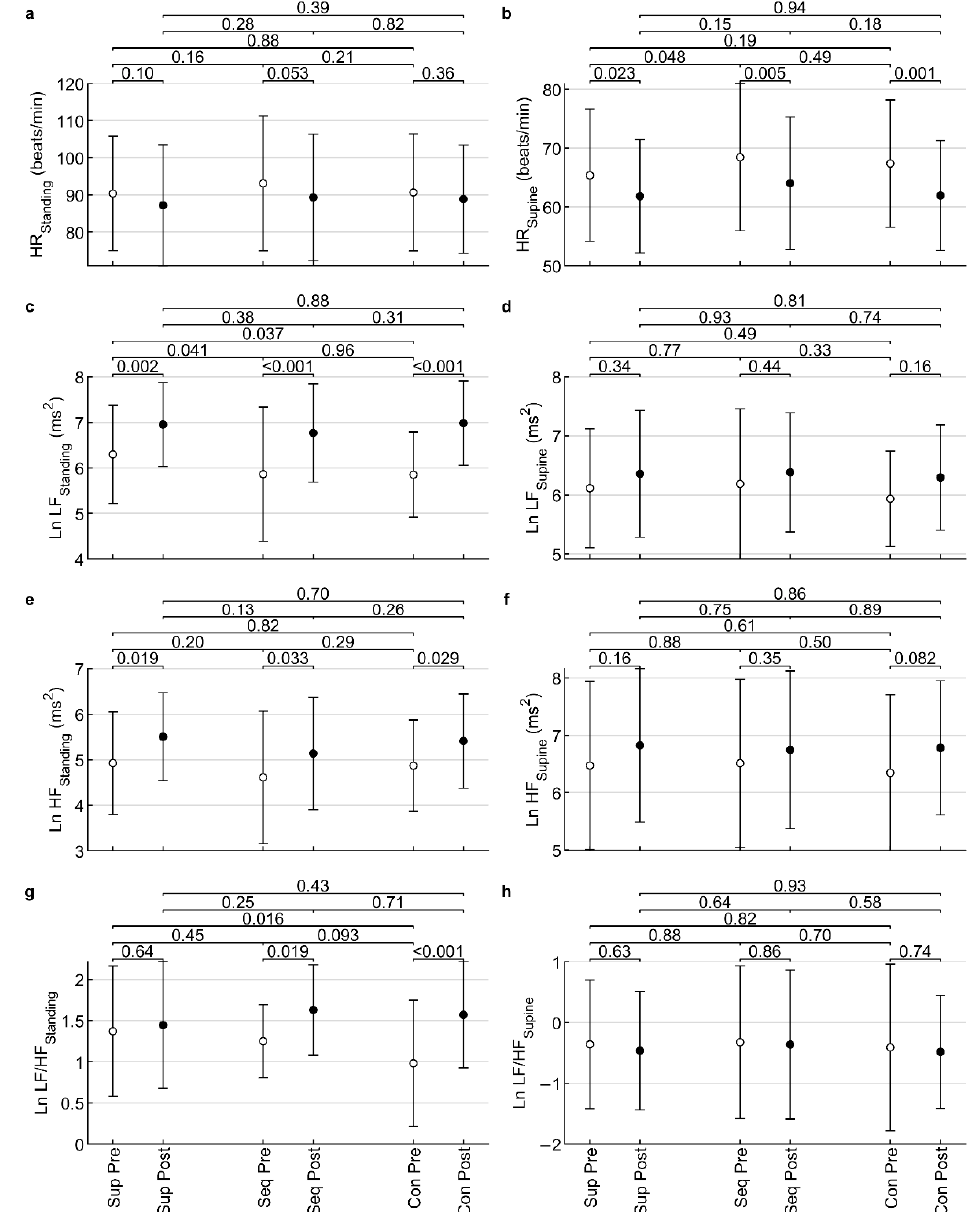
Figure 4. Influence of low-frequency sound on heart rate ( a , b ); low-frequency power ( c , d ); high-frequency power ( e , f ); and low-frequency/high-frequency ratio ( g , h ) in pre/post measures. Standing—standing body position in the orthoclinostatic maneuver; Supine—supine body position in the orthoclinostatic maneuver; Ln—natural logarithm; Sup—placebo supine; Seq—stimulation with amplitude modulation of LFV; Con—constant LFV. The values displayed above the clips are p -values of Fisher’s LSD tests.